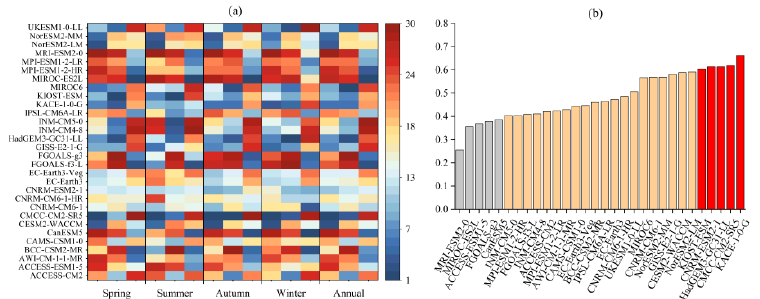
Figure 6. ( a ) Heatmap of the ranking of the performance of the CMIP6 models in reproducing the seasonal and annual NWS in China (m·s − 1 ). The grid boxes from left to right present the ranking of the Taylor diagram, BIAS , and IVS , respectively. ( b ) Histogram of the MR for each model based on the Taylor diagrams, BIAS , and IVS .